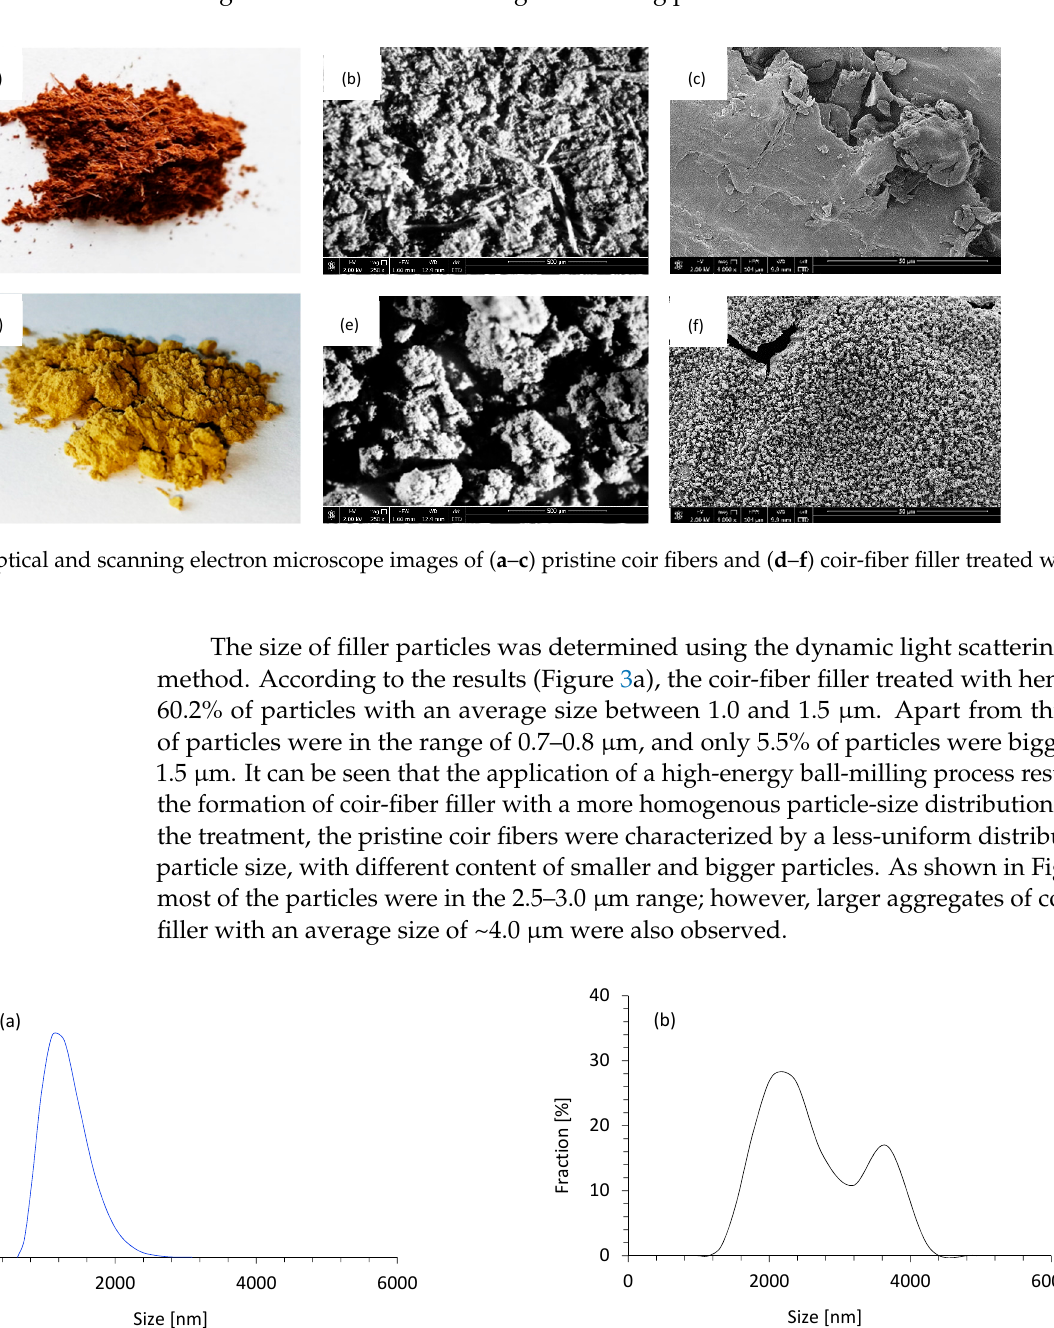
Figure 1. Schematic procedure of PUR composite preparation.